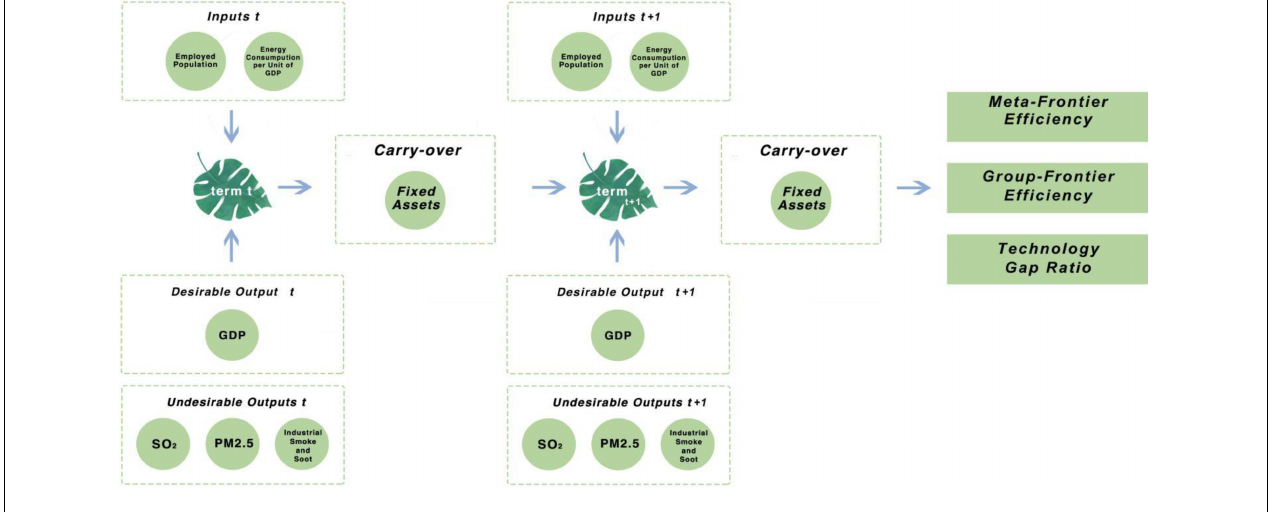
FIGURE 1 | The structure of the Modified MetaFrontier Dynamic SBM model.